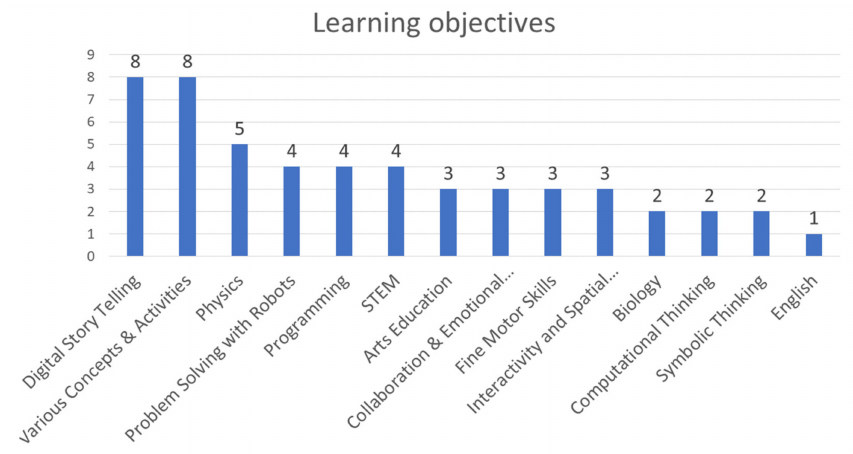
Figure 6. Learning objectives of smart